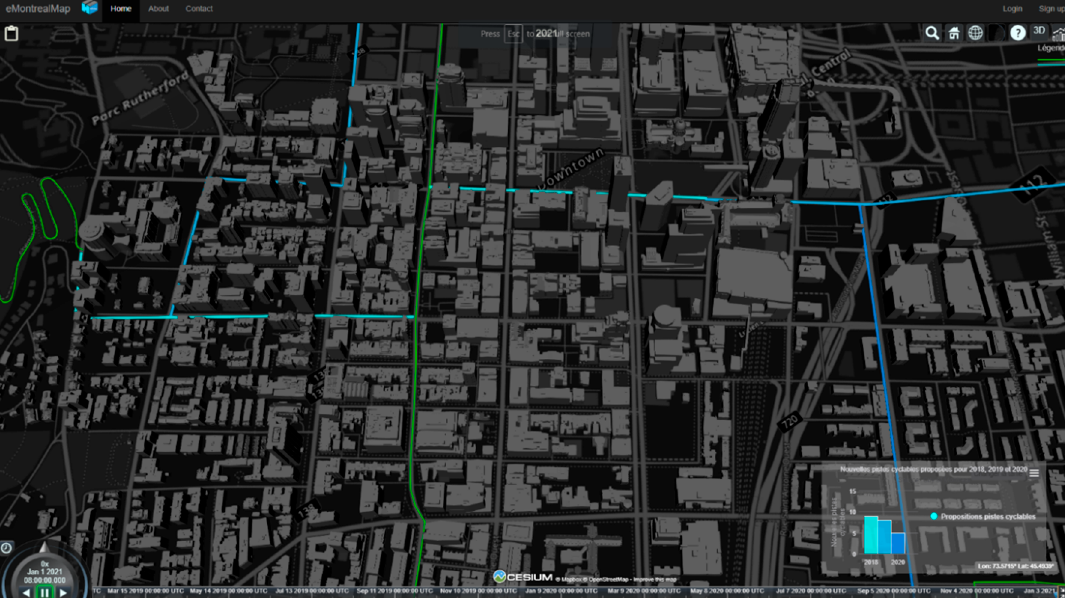
Figure 4. Scenario #1 with future bicycle paths in shade of blue, current bicycle paths in green, and abstract non-textured buildings with a Mapbox dark